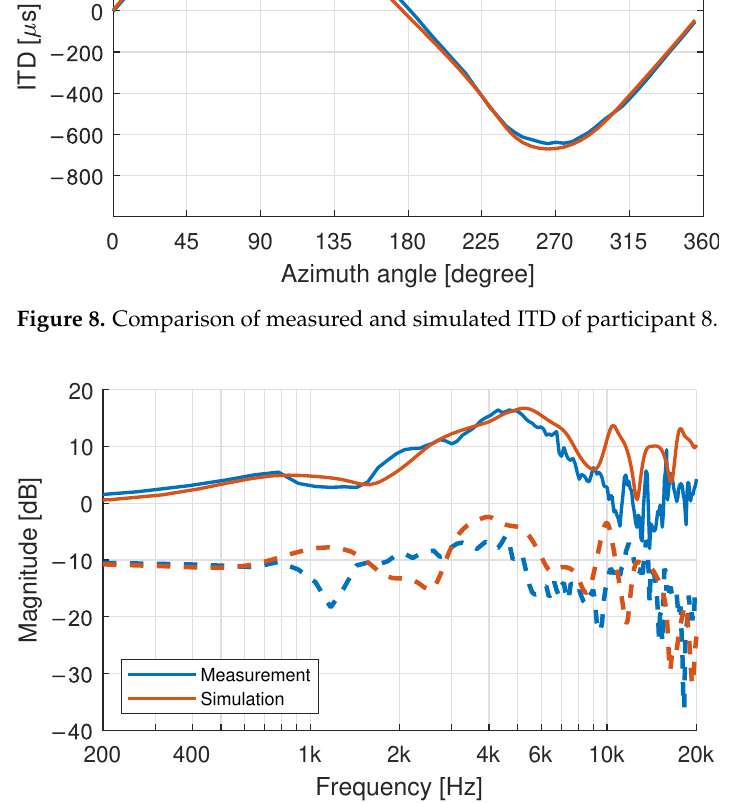
Figure 9. Exemplary comparison of measured and simulated magnitude spectra of a participant at 15-degree azimuth in the horizontal plane. The right ear transfer function ( dashed line ) is offset by − 10 dB compared to the left ( solid line